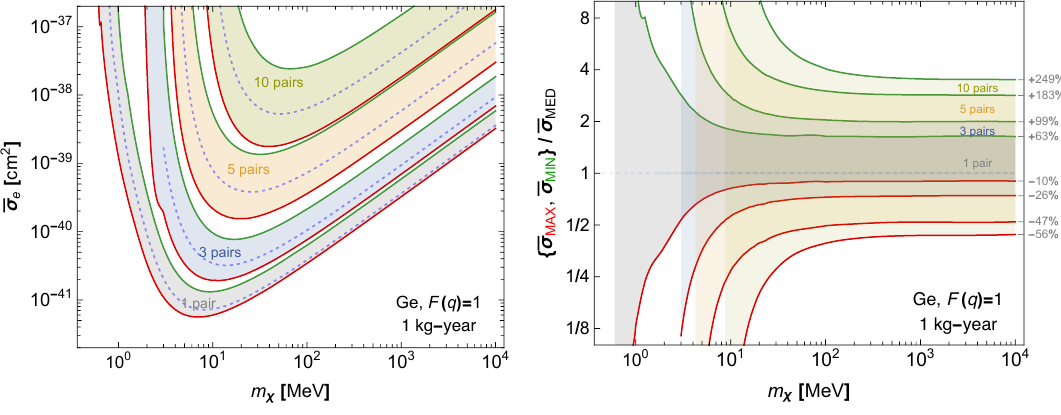
Figure 4 . The same as (cid:12)gure 3 but for germanium